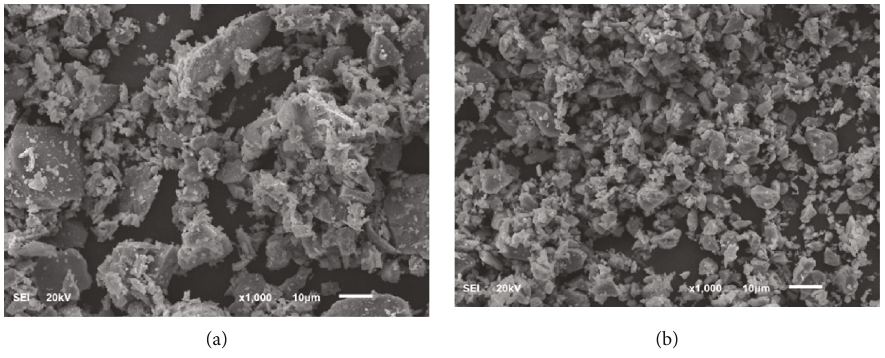
Figure 3: SEM images for (a) hematite and (b) ilmenite.